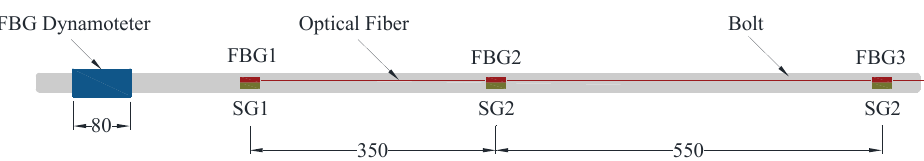
Figure 4. Encapsulated FBG force-measuring bolt picture ( a ); FBG dynamometer picture ( b ). Figure 5. FBGforce-measuring bolt. Figure 5. FBG force-measuring bolt. Figure 5. FBG force-measuring bolt.